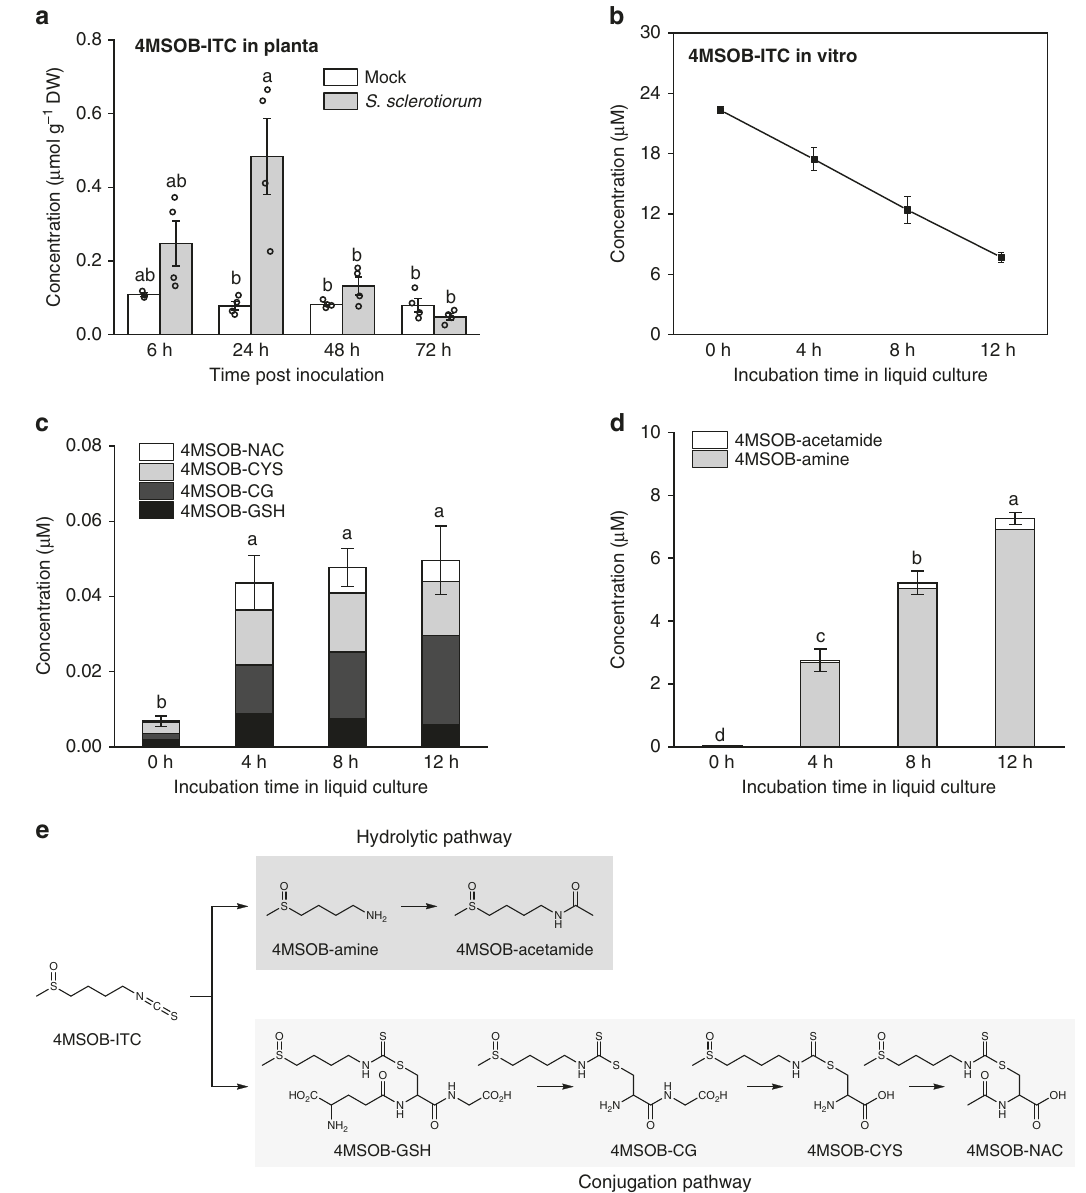
Fig. 2 4MSOB-ITC is degraded by the fungus S. sclerotiorum . a Quanti fi cation of 4MSOB-ITC in A. thaliana plants with and without S. sclerotiorum . Data represent mean ± SEM ( n = 4 inoculated plants) and were analyzed by a Kruskal – Wallis rank sum test ( p < 0.01) followed by a Games – Howell post-hoc test. Different letters above the bars indicate signi fi cant differences at p < 0.05. b Quanti fi cation of 4MSOB-ITC in fungal cultures during a time course. Twenty- fi ve micromolar 4MSOB-ITC was used for each fungal culture. Data were analyzed by a linear regression ( R 2 = 0.94, p < 0.001). Quanti fi cation of c 4MSOB-ITC mercapturic acid pathway conjugates, and d 4MSOB-ITC hydrolytic degradation products 4MSOB-amine and 4MSOB-acetamide, in the fungus-inoculated liquid medium supplemented with 4MSOB-ITC. Data represent mean ± SEM ( n = 3 independent fungal cultures) and were analyzed by one-way ANOVA ( p < 0.001) followed by Tukey ’ s post-hoc test. Different letters above the bars indicate signi fi cant differences at p < 0.05. e Proposed pathways for the degradation of 4MSOB-ITC by S. sclerotiorum . 4MSOB-ITC, 4-methylsul fi nylbutyl isothiocyanate; 4MSOB-GSH, 4MSOB-ITC glutathione conjugate; 4MSOB-CG, 4MSOB-ITC cysteinylglycine conjugate; 4MSOB-CYS, 4MSOB-ITC cysteine conjugate; 4MSOB-NAC, 4MSOB-ITC N - acetylcysteine conjugate; 4MSOB-amine, 4-methylsul fi nylbutylamine; 4MSOB-acetamide, 4-methylsul fi nylbutylacetamide. Source data are provided as a Source data fi